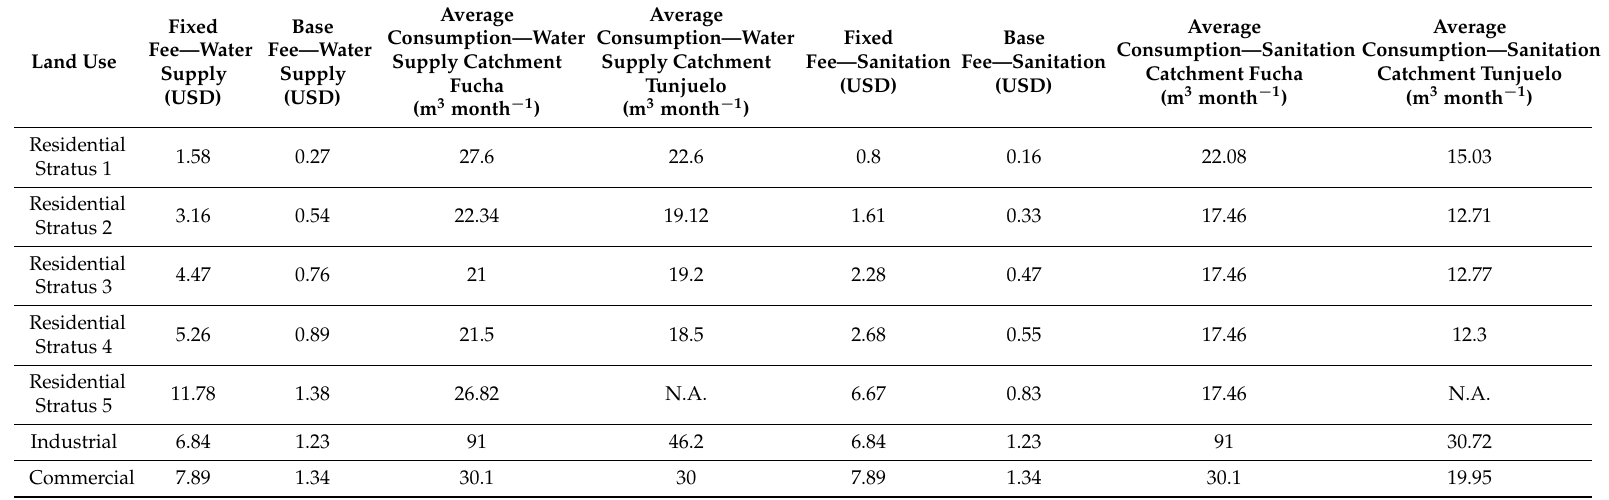
Table 3. Cost to pay for services and values of drinking-water consumption and sewage for Fucha and Tunjuelo